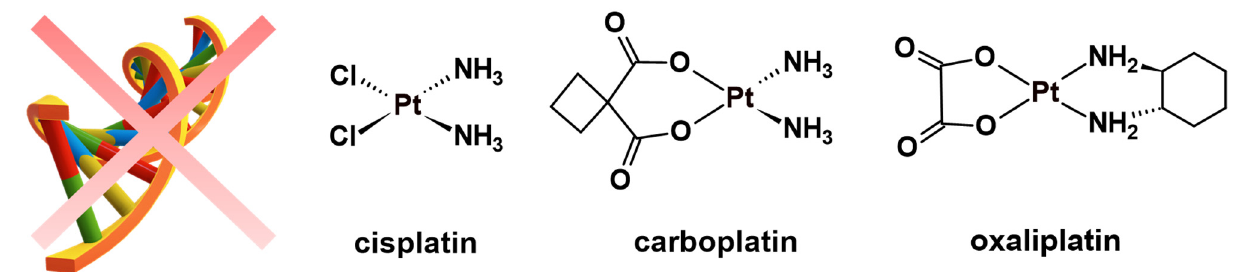
Figure 1. Chemical structures of classical DNA-binding chemotherapeutics.